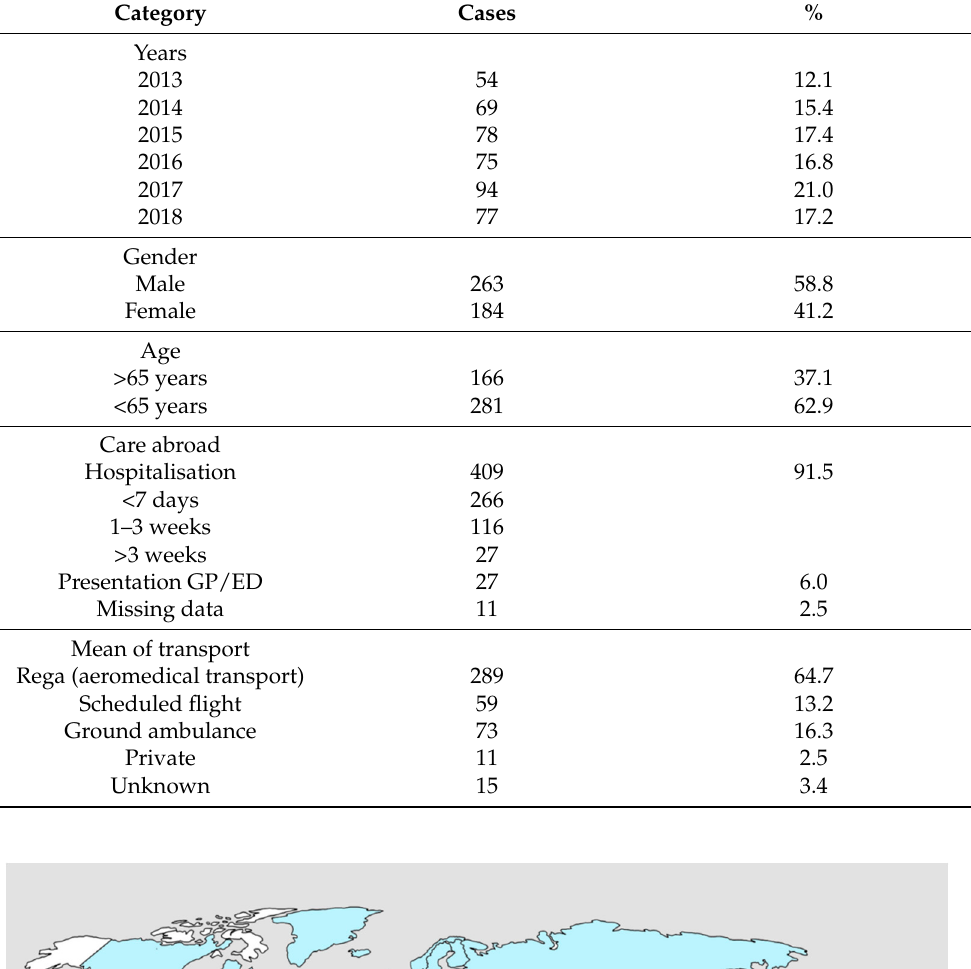
Table 1. Overview results.